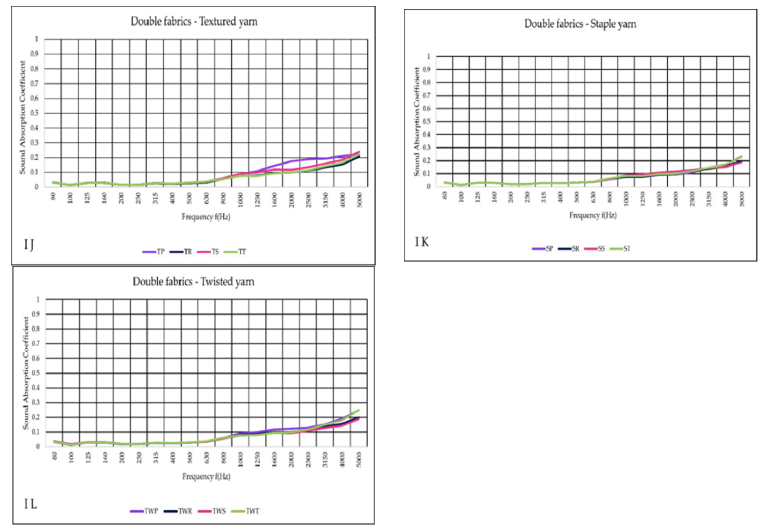
Figure 8. Sound absorption coefficient ( α ) versus frequency f (Hz) result of the variant (I), ( J – L ) double woven fabric.